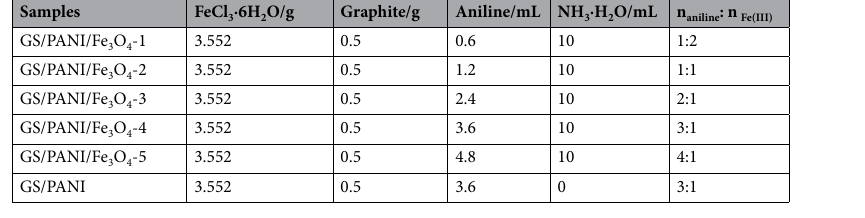
Table 1. The conditions of the samples